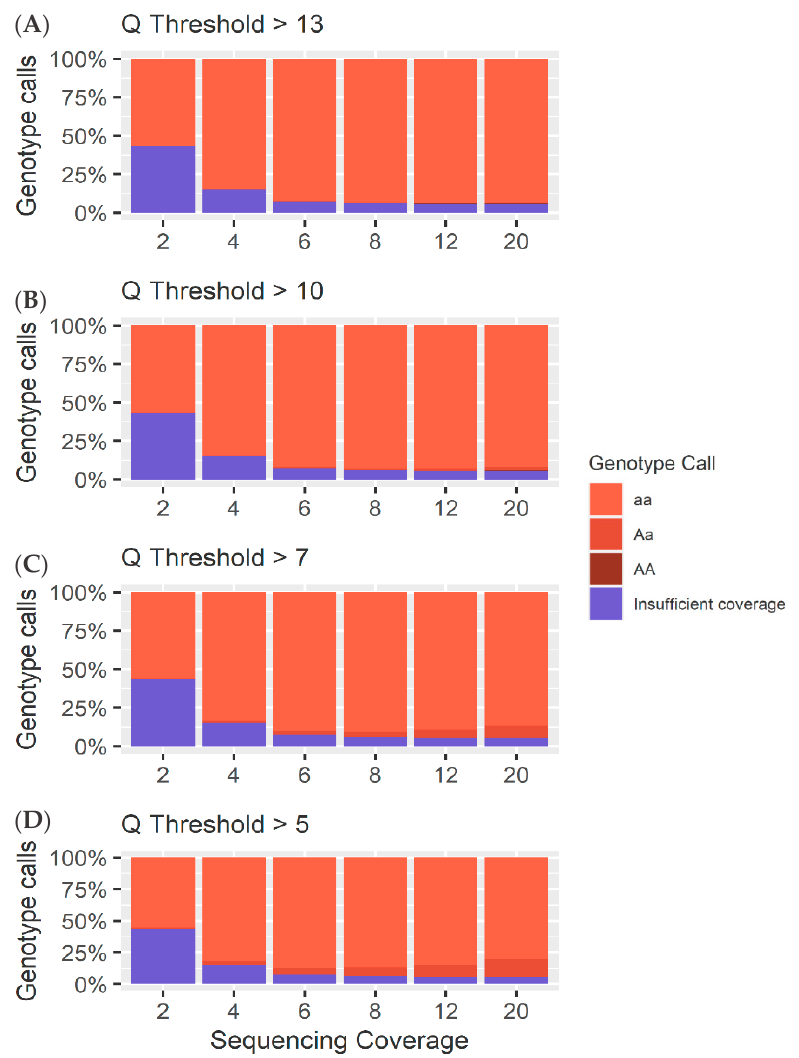
Figure 8. ( A ) A breakdown of the di ff erent calls (Table S2) for each sequencing coverage at a Q threshold of 13 for the 10,000 homozygous loci. ( B ) A breakdown of the di ff erent calls (Table S2) for each sequencing coverage at a Q threshold of 10 for the 10,000 homozygous loci. ( C ) A breakdown of the di ff erent calls (Table S2) for each sequencing coverage at a Q threshold of 7 for the 10,000 homozygous loci. ( D ) A breakdown of the di ff erent calls (Table S2) for each sequencing coverage at a Q threshold of 5 for the 10,000 homozygous loci.